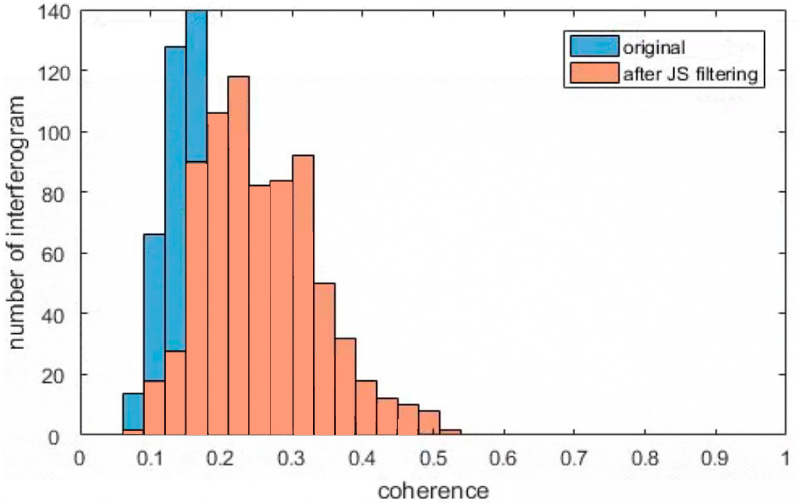
Figure 6. The differential interferograms with 10:2 multilook for parts of the track 26-2 with the interferometric pair of 30 October 2021 vs. 23 November 2021 and 22 May 2022 vs. 3 June 2022 in SAR coordinate. ( a , c ) Original phase, ( b , d ) JS-InSAR optimized phase.